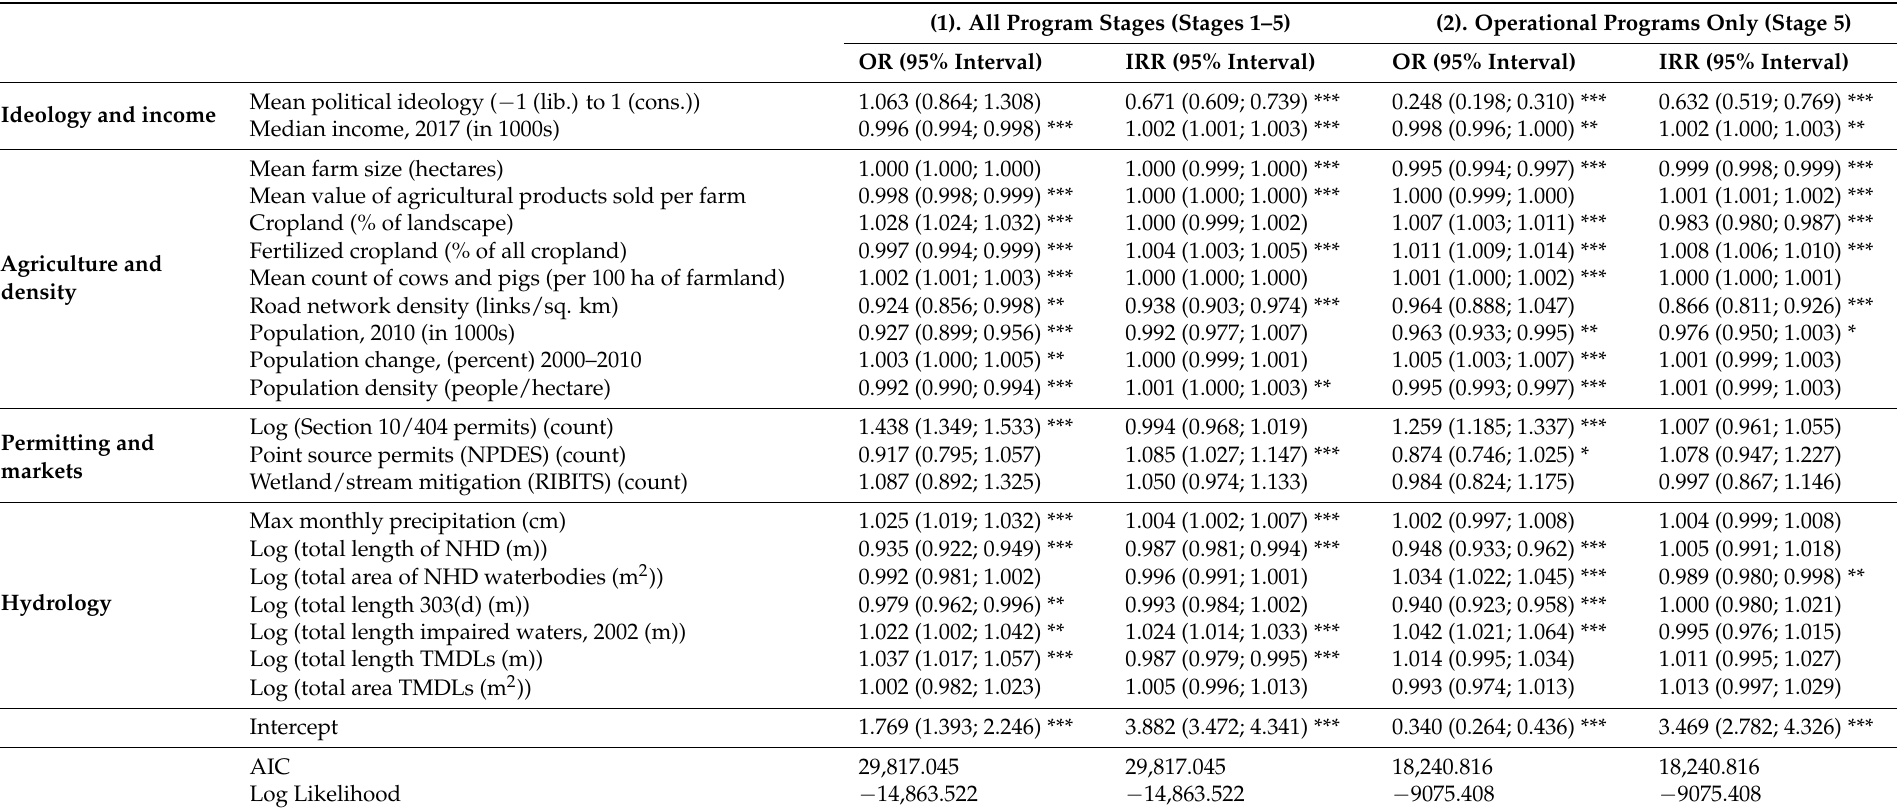
Table A2. Hurdle regression model results showing sensitivity analysis whereby hydrological variables (except precipitation) are summarized to the tract-level (50% overlap per discussion in Appendix B). Hurdle model predictions of existence and abundance of (1) operational and nonoperational water quality trading programs (all Stages 1–5) and (2) operational water quality trading programs (Stage 5 only). Depicts effects on odds ratios (OR) for binary logistic regressions and on incident rate ratios (IRR) for truncated negative binomial regressions, with 95% confidence intervals for each. n = 6940 tracts for all. * p < 0.1; ** p < 0.05; *** p <